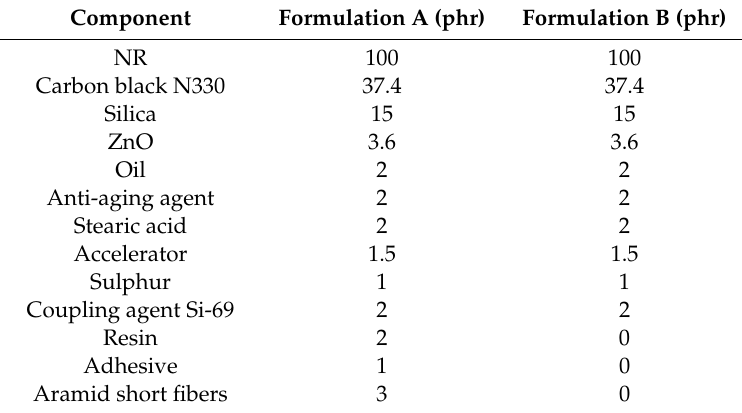
Table 1. Compound formulation.